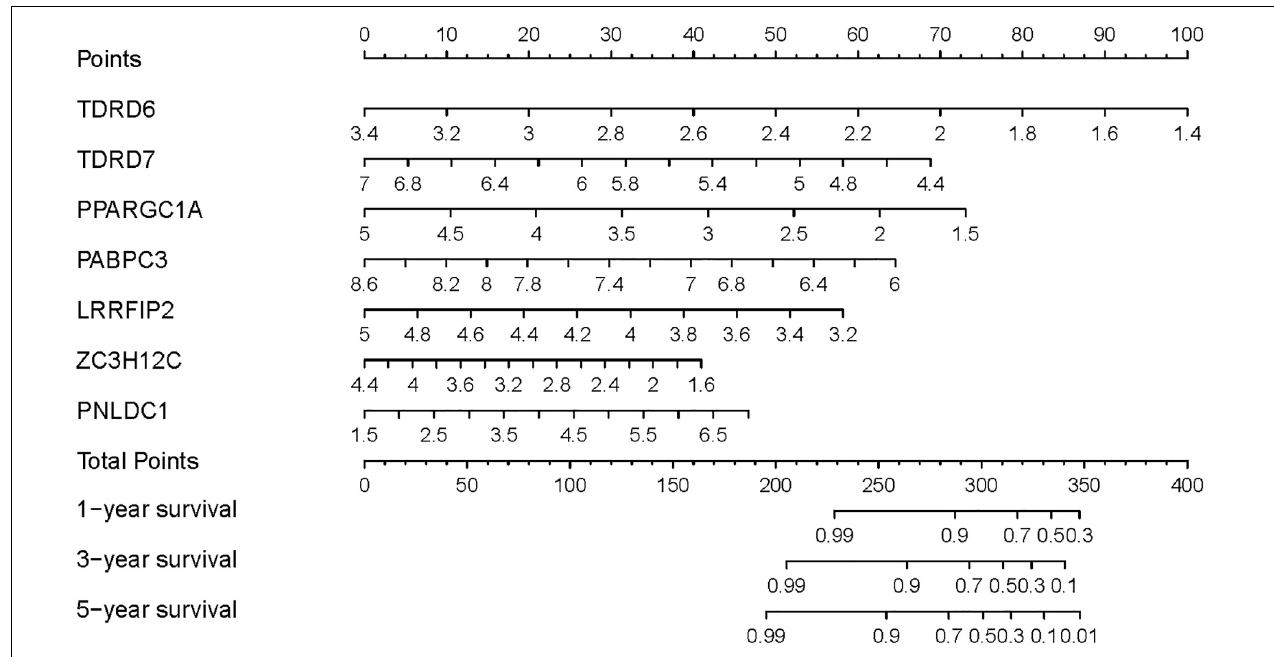
FIGURE 6 | Prognostic nomogram based on the RBP-related signature for prediction of 1-, 3-, and 5-year survival rates.